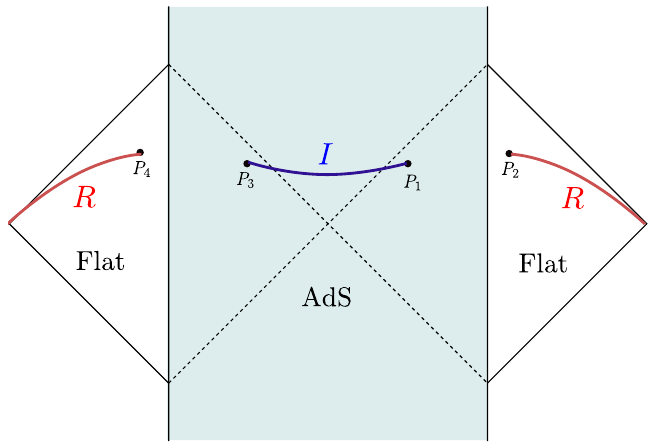
Figure 3 . Eternal black hole in AdS 2 , glued to Minkowski space on both sides. Hawking radiation is collected in region R , which has two disjoint components. Region I is the island. The shaded region is coupled to JT gravity.